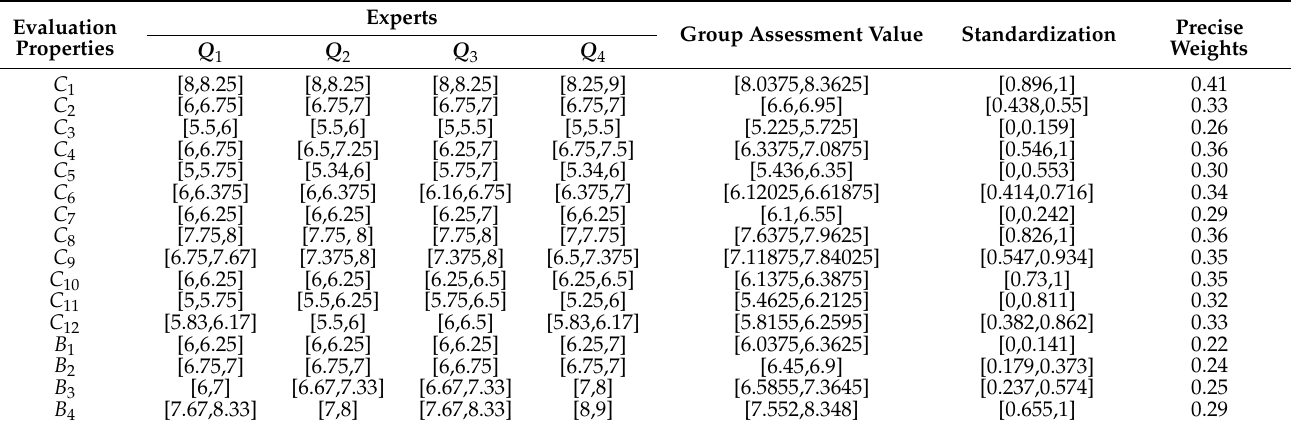
Table 4. Expert weighting